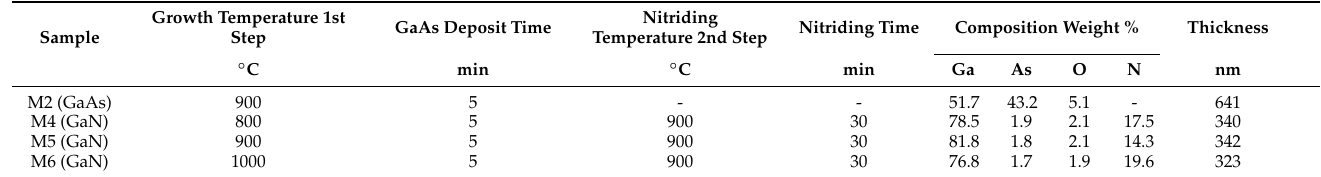
Table 1. Parameters of GaAs films before and after nitriding, EDS quantification results, and pro- filometry